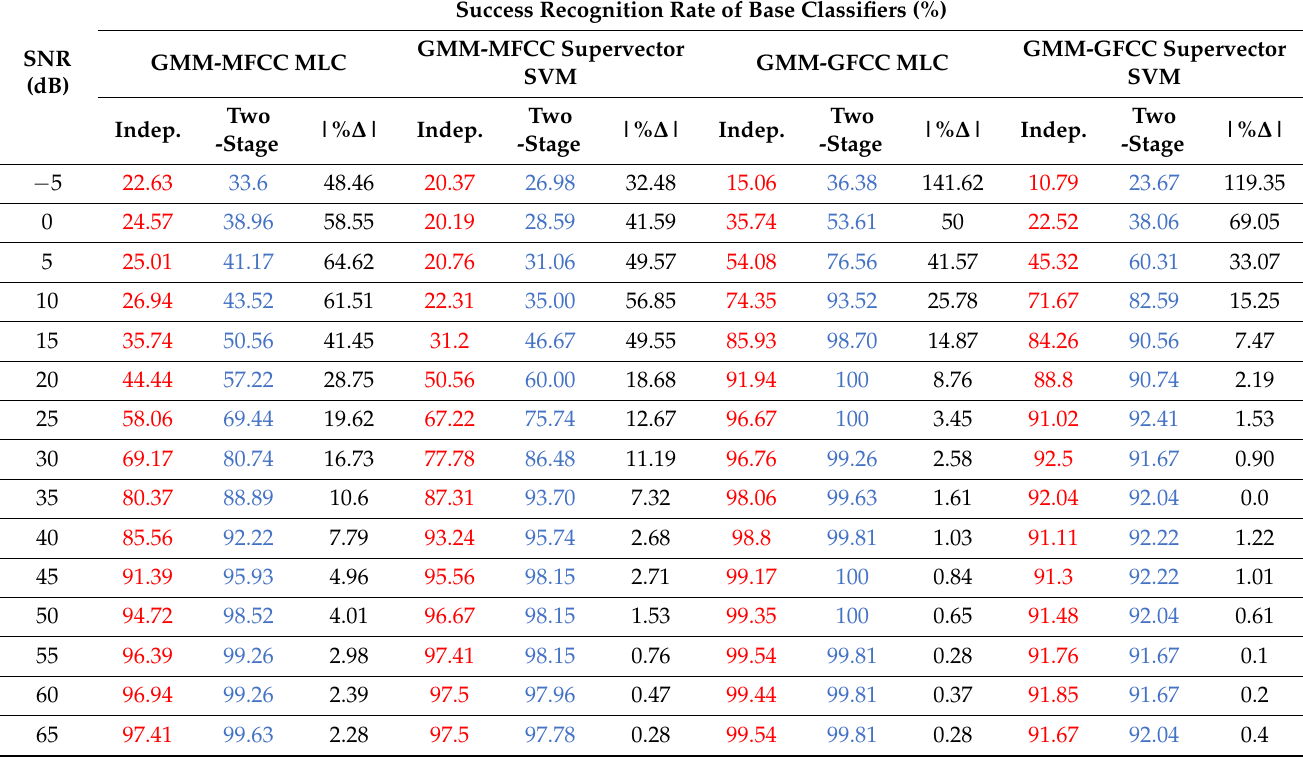
Figure 21. Rank-1 recognition rates of the fusion system and the base classifiers (two-stage) on utterances distorted with street noise. Table 1. Comparison of recognition rates for the base classifiers when they are used within the proposed system (blue) with that of the same base classifiers when they are used independently (red) on utterances distorted with white noise.